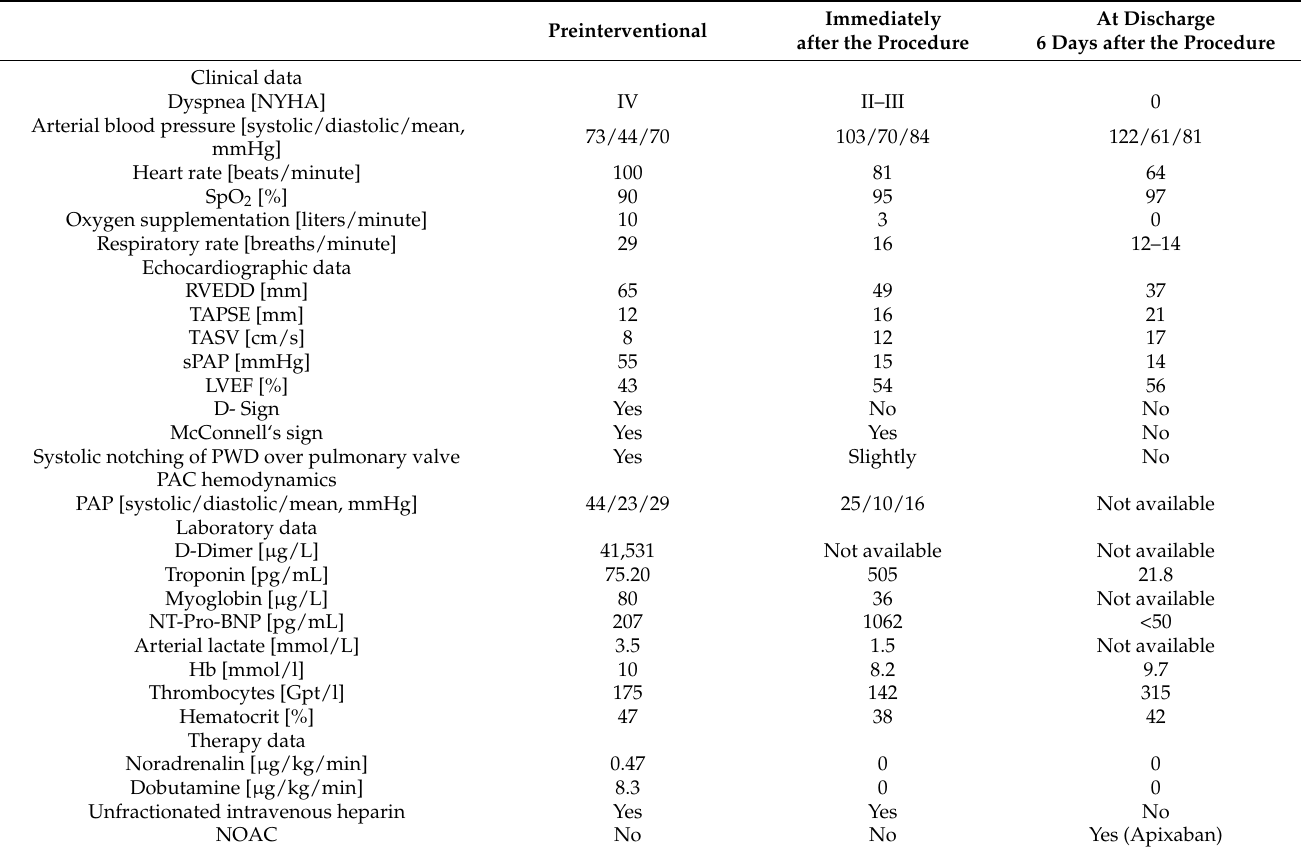
Table 1. Selection of pre- and post-interventional patient characteristics following percutaneous thrombectomy of bilateral pulmonary embolism and autotransfusion.